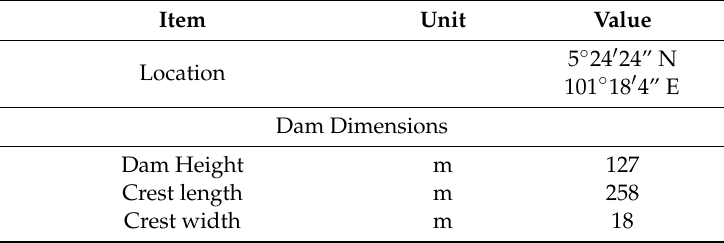
Table 1. Dimensions and hydraulic information for the Temenggor